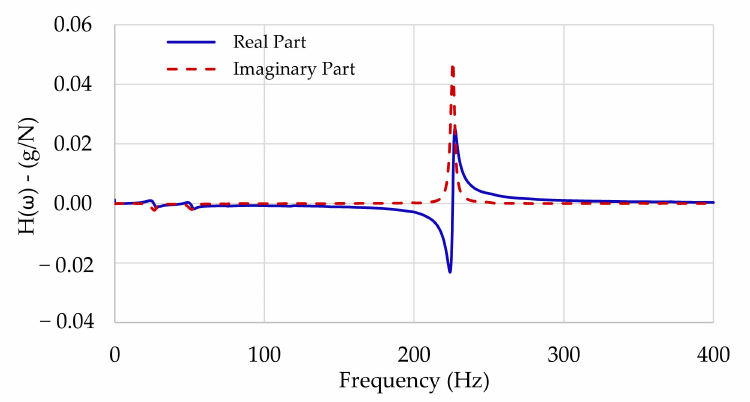
Figure 2. FRF in terms of real and imaginary